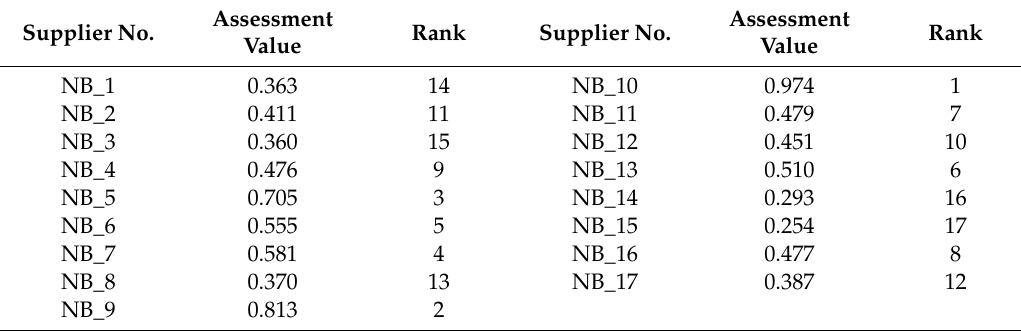
Table 5. Results of comprehensive assessment for operation quality of smart meters. Supplier